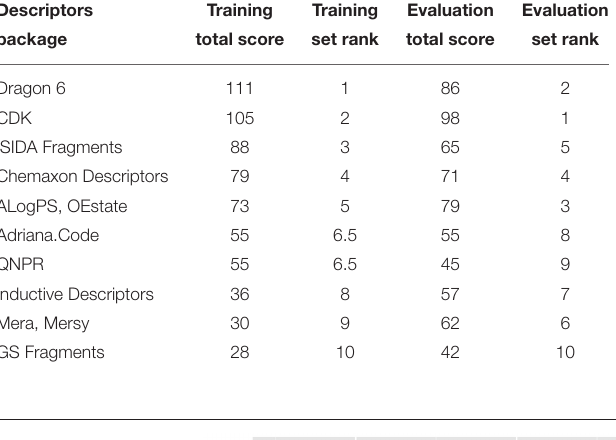
TABLE 2 | Comparison of the performance of different descriptor packages in constructing QSAR models for in vitro pathway disruption prediction.